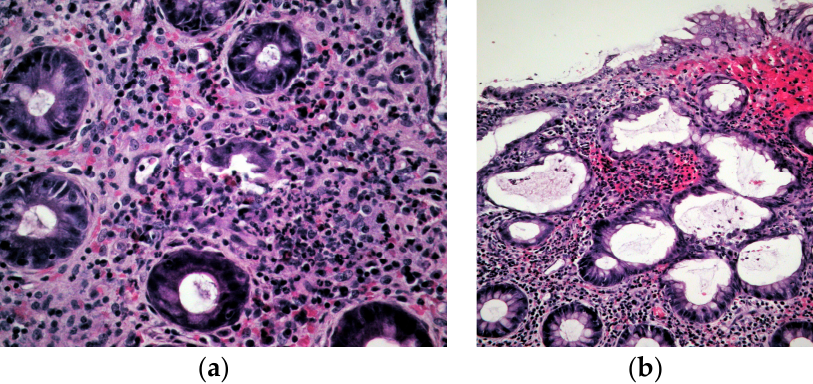
Figure 2. Histology of colonic mucosa: ( a ) Destructed crypt with granulocyte, eosinophil, and plasma cell infiltrate. Hematoxylin and eosin, ×400; ( b ) Neutrophil infiltrate in upper half of lamina propria in colonic mucosa. Hematoxylin and eosin, ×200.